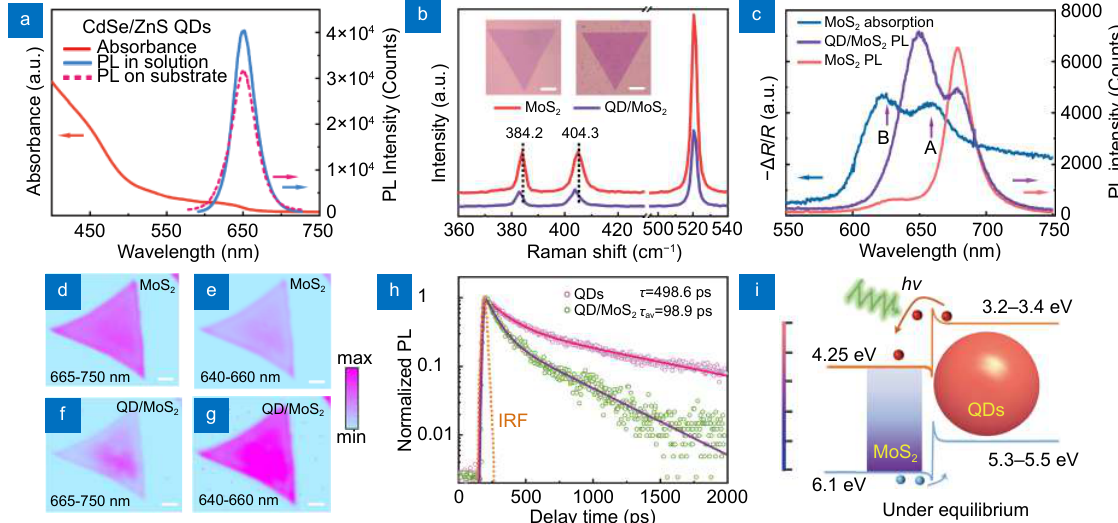
Fig. 2 | Optical and spectral characteristics of QDs, MoS 2 monolayer and mixed-dimensional vdWHs. ( a ) The UV-visible absorption spec- trum (orange) of CdSe/ZnS QDs in 0.2 mg·L −1 solution. PL spectra of QDs in solution (blue) and on SiO 2 /Si substrate (dotted line). ( b ) Raman spectra of MoS 2 monolayer and QD/MoS 2 heterostructures. E 1 2g and A 1g modes are 384.2 cm −1 and 404.3 cm −1 for MoS 2 monolayer, respect- ively, and the E 1 2g peak shifts blue to 383.3 cm −1 in heterostructures. Insets present the optical microscopy images of MoS 2 monolayer and het- erostructure. The scale bars are 6 μm. ( c ) The absorption (black) and PL (red) spectra of MoS 2 monolayer. The PL intensity maps of MoS 2 monolayer are measured at the spectral ranges of ( d ) 665−750 nm and ( e ) 640−660 nm. The PL intensity maps of heterostructures with 0.025 mg·L −1 QDs are measured at the spectral ranges of ( f ) 665−750 nm and ( g ) 640−660 nm. All the scale bars in mapping images are 5 μm. ( h ) Time-resolved photoluminescence (TRPL) spectra of QDs and QD/MoS 2 heterostructures. The average lifetimes of QDs and heterostrutures are 498.6 ps and 98.9 ps, respectively. ( i ) The schematic view of energy band for QD/MoS 2 heterostructures under the light